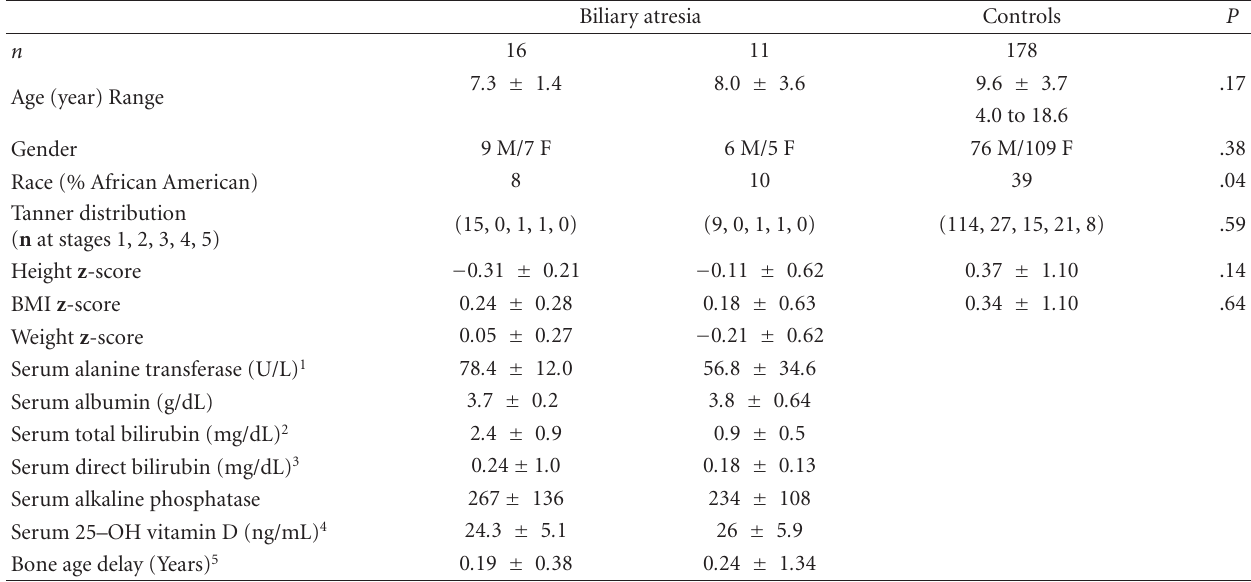
Table 1: Subject characteristics between the ages of 3 and 18.